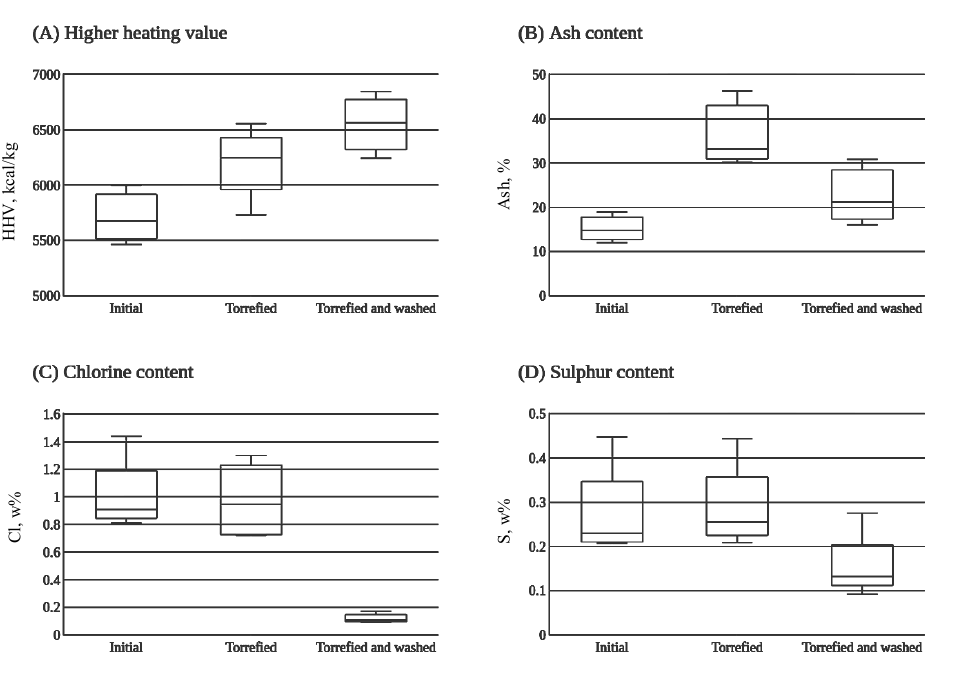
Fig. 4. Changes in composition and properties of RDFs during torrefaction and subsequent